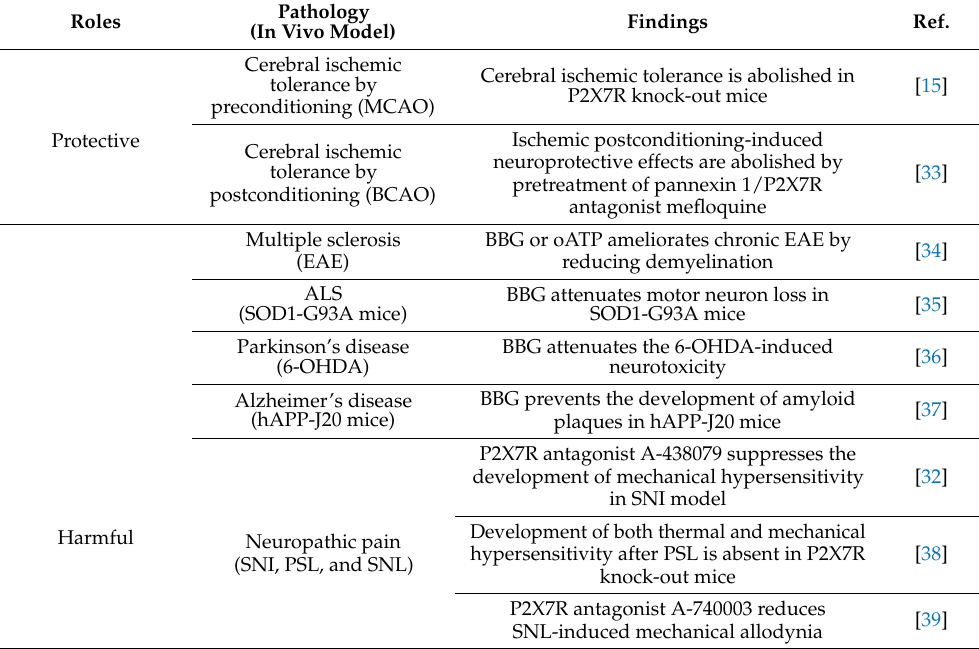
Table 1. Role of P2X7 receptors in central nervous system